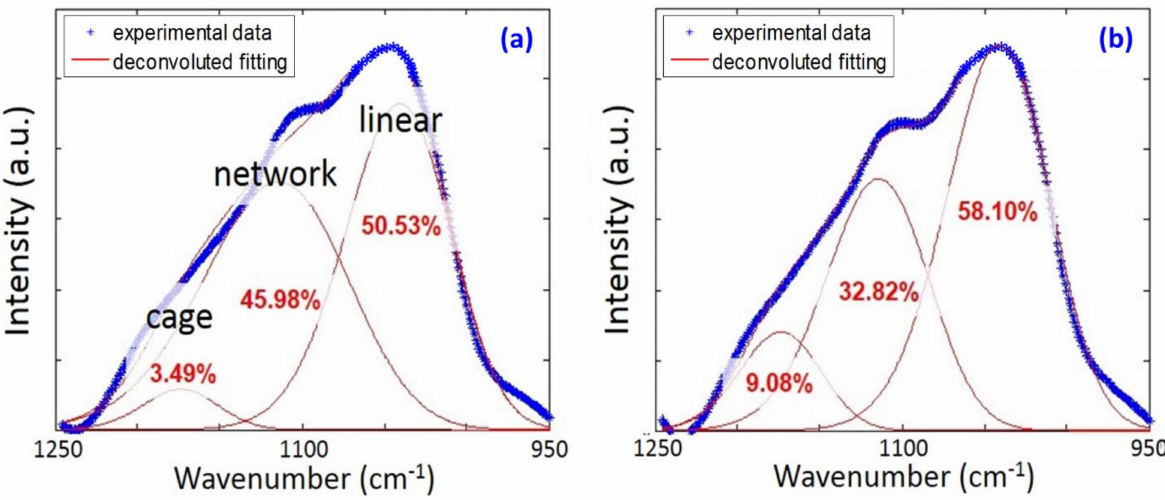
Figure 5. Deconvolution of Si-O-Si backbone peak in FTIR spectra; ( a ) subtractive film and ( b ) structural film.